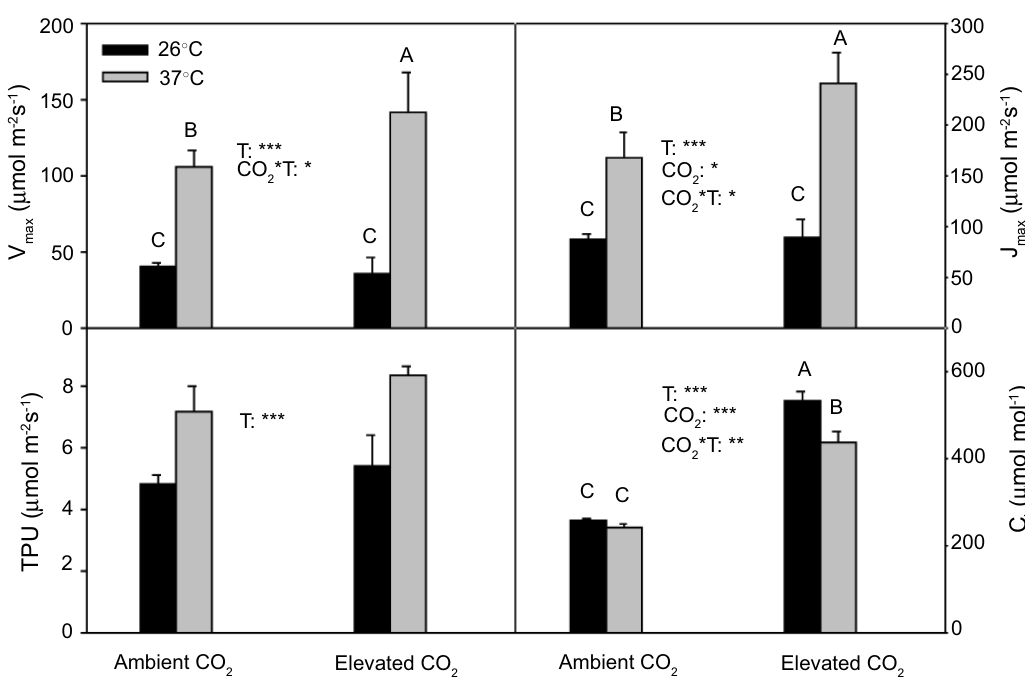
Figure 3. V , J , TPU and C in current year white birch seedlings. V cmax max i measured at 26°C and 37°C under ambient CO and elevated CO 2